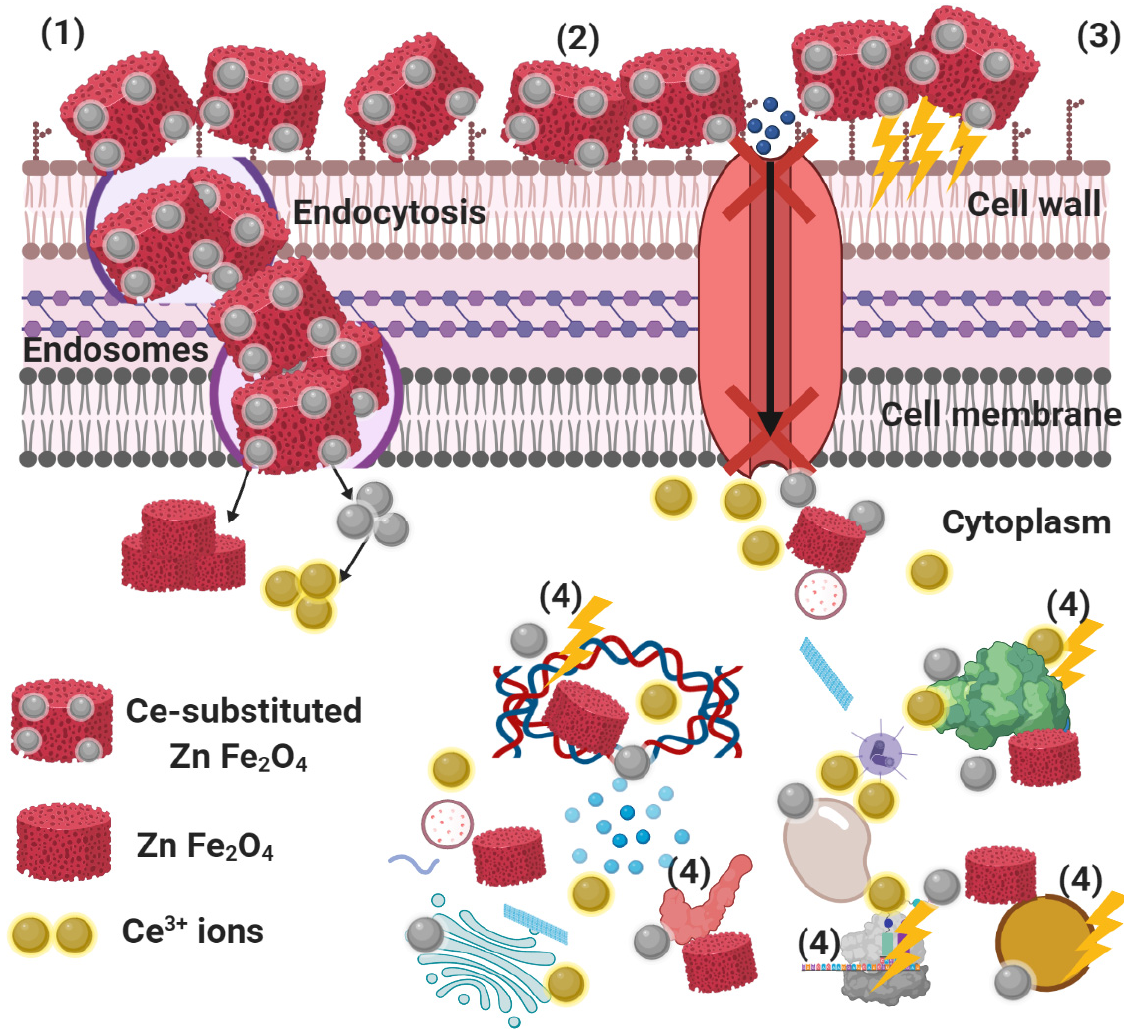
Figure 11. Proposed schematic representation illustrating the four prominent methods of antimicrobial activity of ZnCe x Fe 2 − x O 4 ; X = 0.06, where ( 1 ) ZnCe x Fe 2 − x O 4 ; X = 0.06 adheres to the bacterial cell surface and results in membrane damage and altered transport activity; ( 2 ) ZnCe x Fe 2 − x O 4 ; X = 0.06 creates and increases ROS, leading to cell damage; ( 3 ) ZnCe x Fe 2 − x O 4 ; X = 0.06 blocks the transport of ions to and from the bacterial cell; and ( 4 ) ZnCe x Fe 2 − x O 4 ; X = 0.06 penetrates the bacterial cells and interacts with cellular organelles and biomolecules, affecting the cellular machinery, modulating the cellular signal system, and causing cell death. ZnCe x Fe 2 − x O 4 ; X = 0.06 may serve as a vehicle to effectively deliver Ce 3+ ions to the bacterial cytoplasm and membrane, where a proton motive force would decrease the pH to less than 3.0 and therefore improve the release of Ce 3+ .